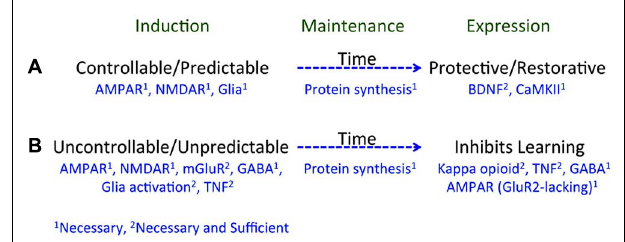
FIGURE 3 |A summary of how training experience affects learning potential. (A) Learning that an environmental event is controllable or predictable depends upon a form of NMDAR-mediated plasticity and is disrupted if glia function is inhibited. Processes initiated during learning (induction) engage a protein synthesis dependent mechanism that maintains the effect over time (memory). Prior experience with controllable/predictable stimulation has a long-term protective/restorative effect that enables instrumental learning and blocks both the learning impairment and EMR induced byVIS.These effects depend upon BDNF and CaMKII. (B) Exposure to uncontrollable/unpredictable shock initiates a process that depends upon the NMDAR, group 1 mGluR, GABA, glia activation, andTNF.These processes induce a protein synthesis dependent mechanism that maintains the effect over time. Prior experience with uncontrollable/unpredictable stimulation inhibits instrumental learning through a process that involves a kappa opioid,TNF, GABA, and the trafficking of GluR2-lacking AMPA receptors. Superscripts indicate whether a neurobiological mechanism is necessary (1) or necessary and sufficient